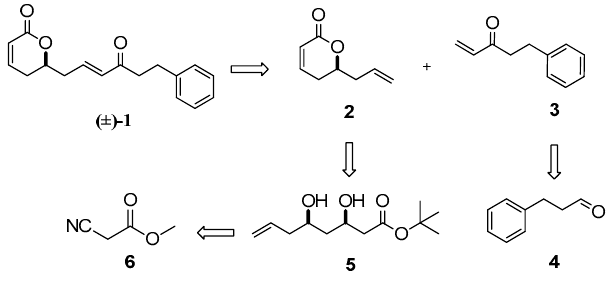
Scheme 1. Retrosynthetic analysis of rugulactone.